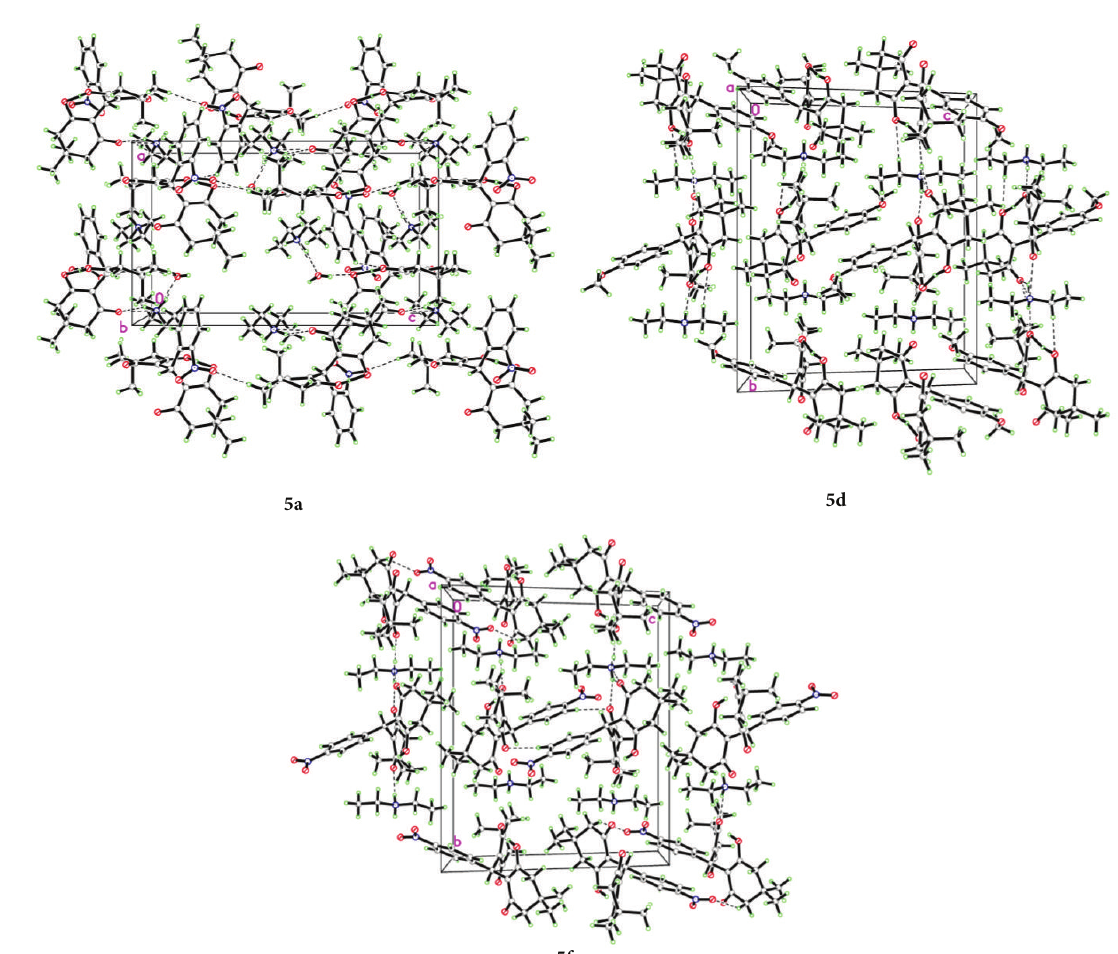
Figure3:Molecularpackingof 5a , 5d ,and 5f viewedapproximatelythree-dimensionalnetwork,along 𝑏 axisandthree-dimensionalnetwork, respectively. Intermolecular interaction is drawn as dashed